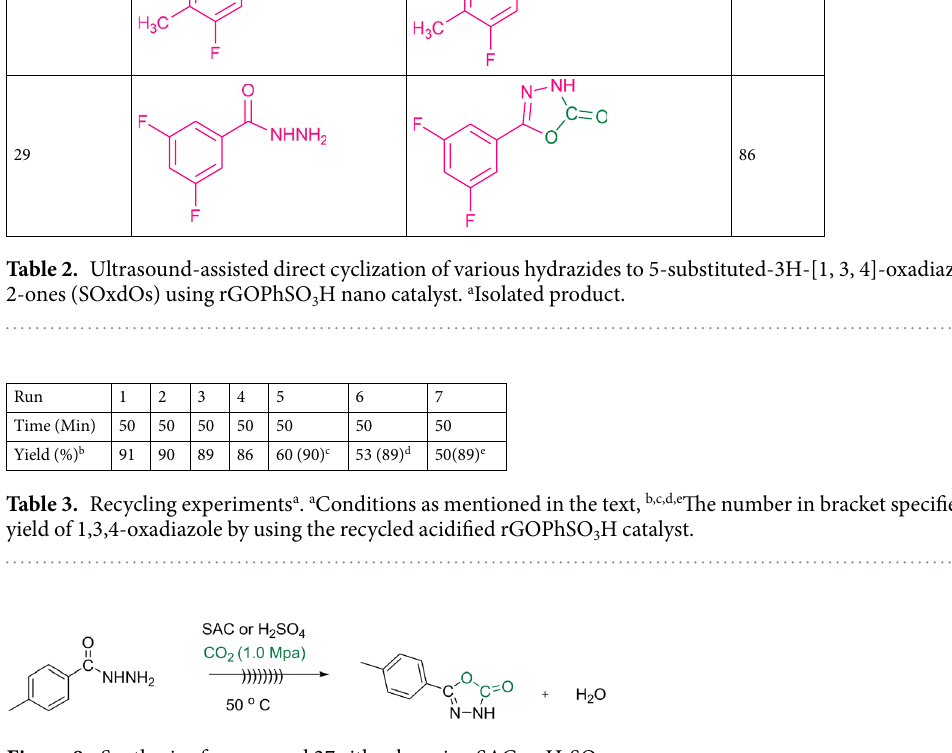
Figure 8. Synthesis of compound 27 either by using SAC or H 2 SO 4